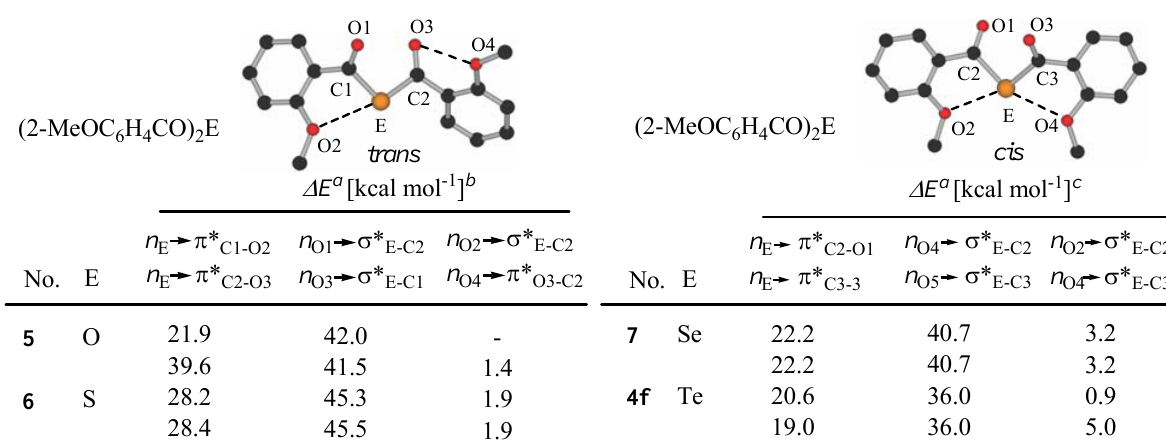
Table 4. NBO analysis of (2-MeOC